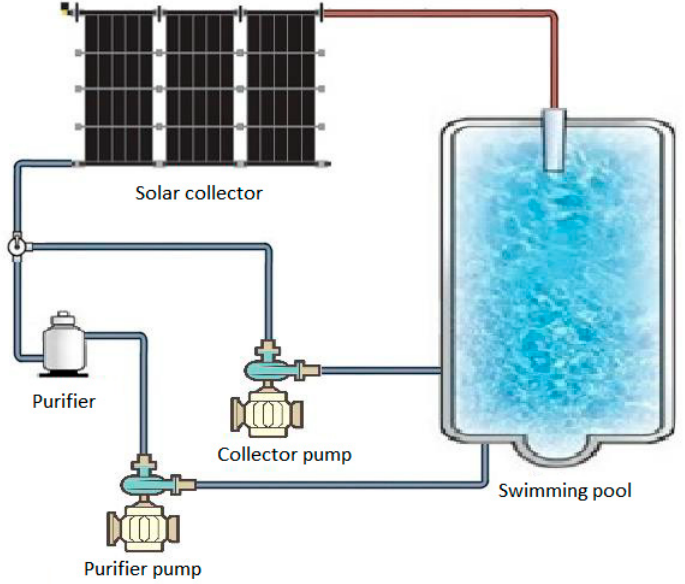
Figure 2. Schematic diagram of the existing components of the installation.